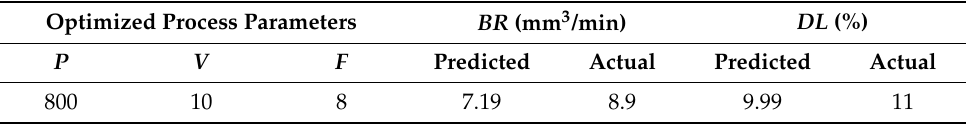
Table 8. Predicted and actual values under optimum process